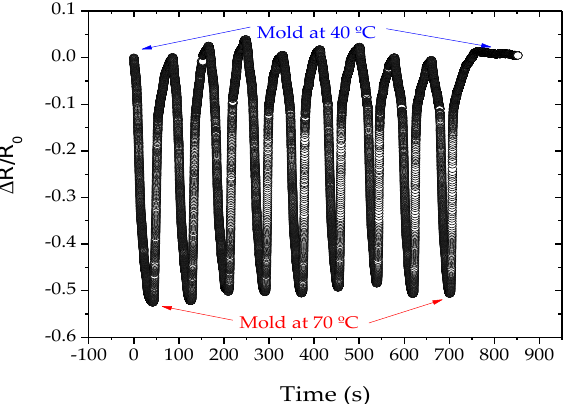
Figure 10. Electrical response of the integrated TiCu(O,N) thermoresistive sensor prepared with a flux of 2 sccm of N 2 + O 2 during repeated temperature cycles.